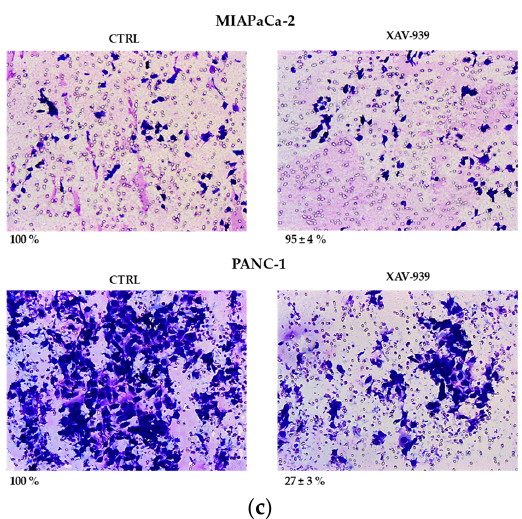
Figure 6. ( a ) Median effect plot showing the inhibition of cell proliferation of PANC-1 and MIAPaCa-2 cells after 48 h treatment with XAV-939 (0.001–100 µM) as log (fraction affected/fraction unaffected) vs. log(dose). ( b ) Effect of XAV-939 on PDAC cells migration was assessed in wound healing assay: XAV-939 treatment restrains PDAC migration function in vitro. WNT- β -catenin inhibition reduced the capacity of tumor cell migration. Differences in wound closure were assessed by ImageJ Lab 1.51 Software. Graph bars represent the percentage of surface area in three independent experiments. Values are expressed as mean ± SD of three independent experiments; **** p -value < 0.0001, by t -test. ( c ) The invasion of PANC-1 and MIAPaCa-2 cells was performed with or without 10 µ M XAV-939 by Boyden chambers assay showing the high capability of the drug in reducing PANC-1 cell invasion.